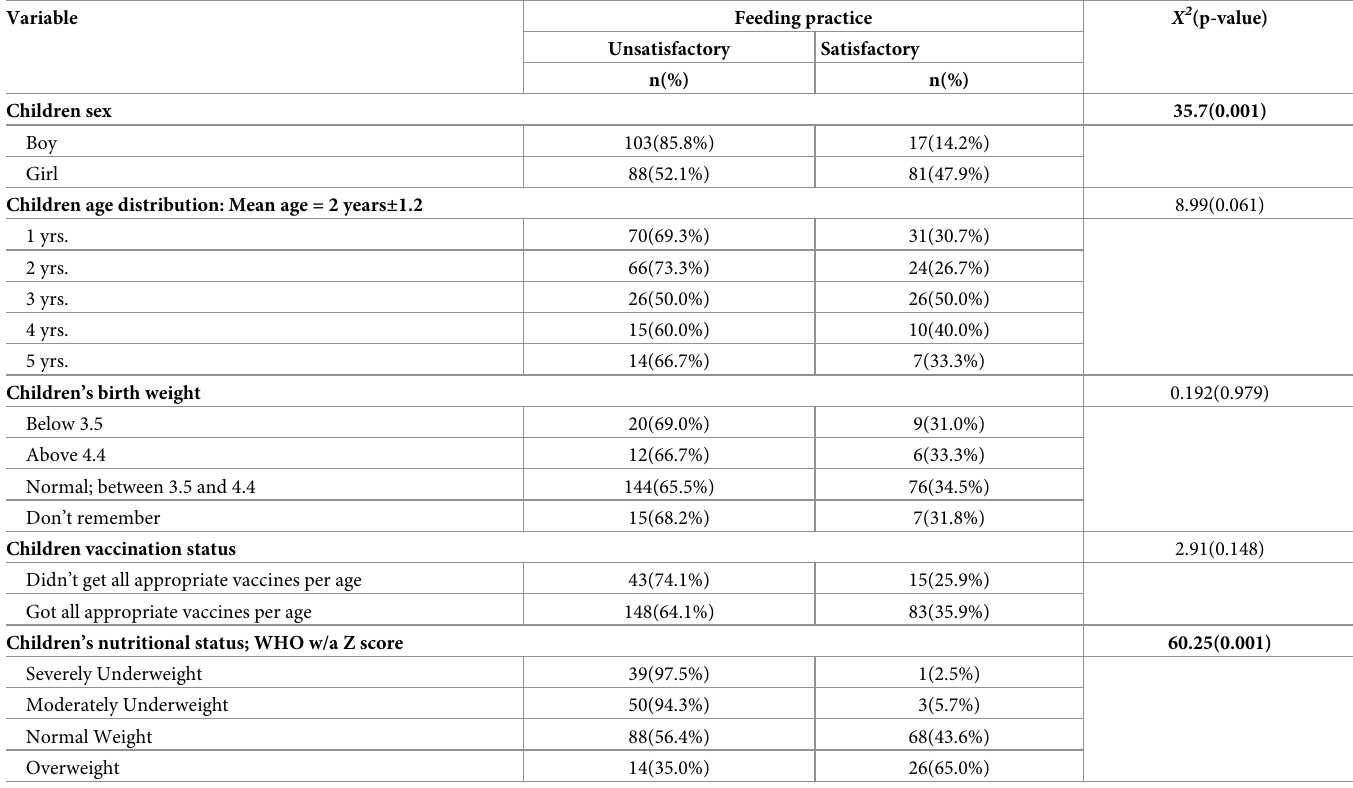
Table 4. Caregivers’ children factors related to feeding practice (n =